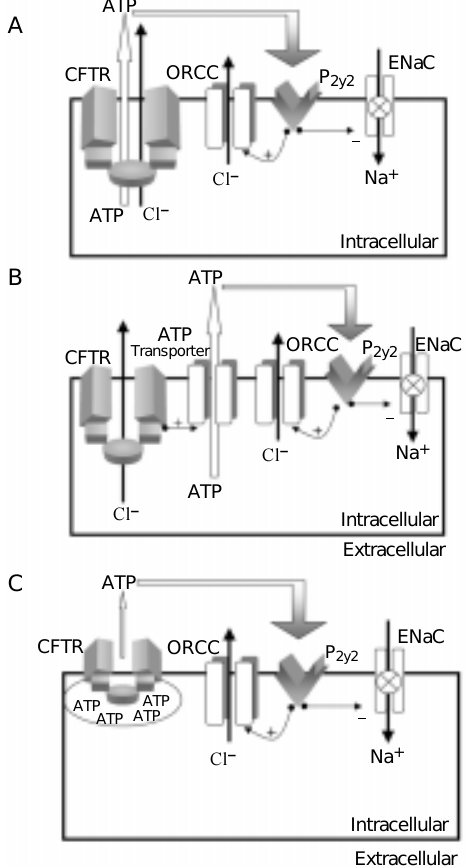
Figure 2 - Membrane model